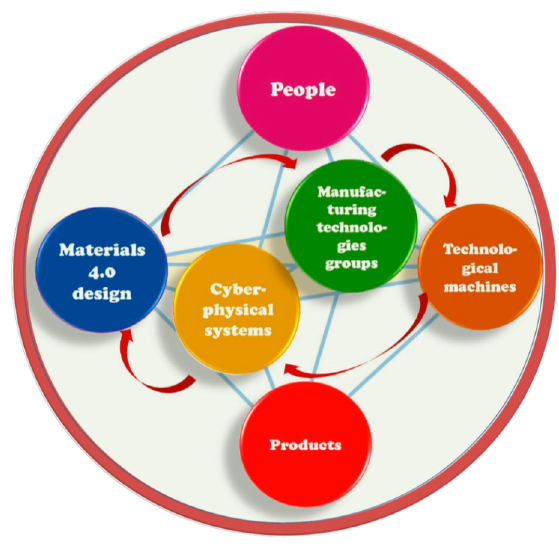
Figure 19. Schematic of the extended holistic Industry 4.0 model.